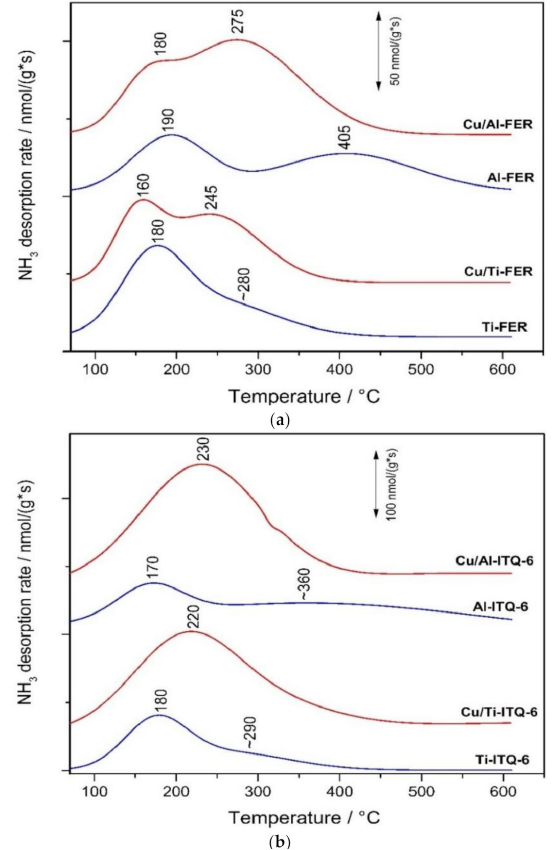
Figure 6. Profiles of NH 3 -TPD obtained for ferrierite ( a ) and ITQ-6 ( b )